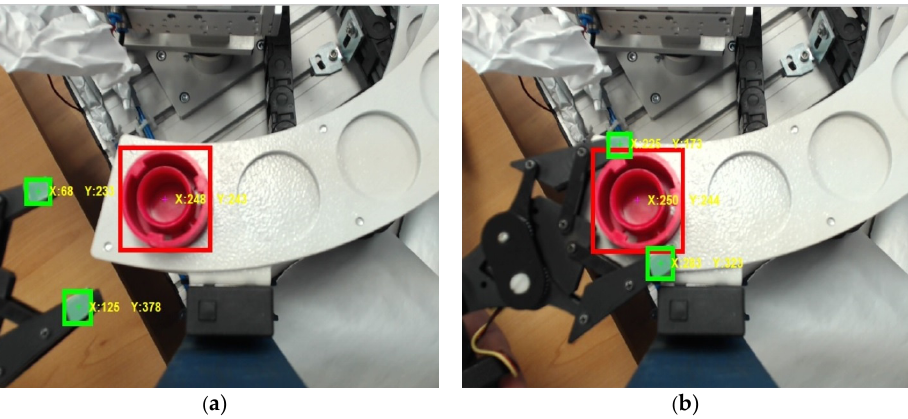
Figure 14. Real-time control of ARS Pioneer 3-DX equipped with RM Pioneer 5-DOF using eye to hand VSS 1 as actuator for precise positioning: ( a ) initial gripper position ; ( b ) final gripper position.